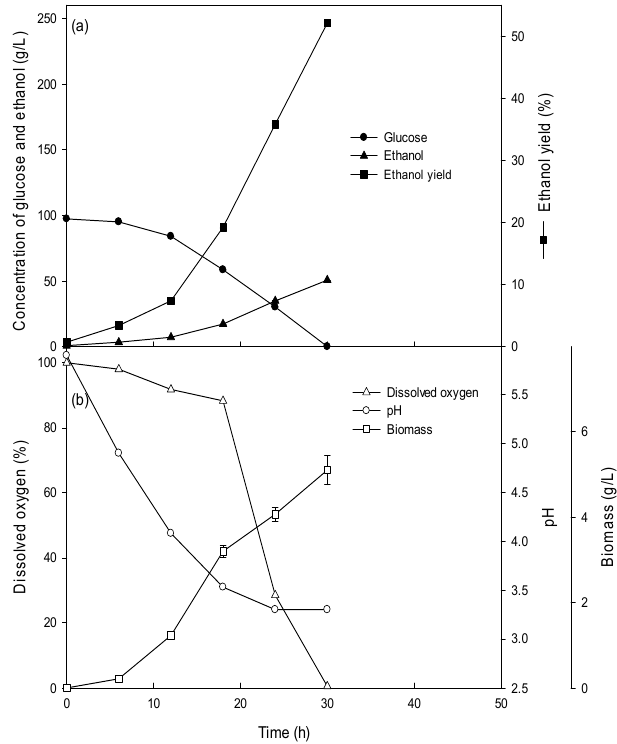
Figure 2. Time course of ( a ) glucose, ethanol concentration, and ethanol yield change, ( b ) dissolved oxygen, pH, and biomass in the batch cultures of S. cerevisiae BCRC 21812. The initial glucose concentration was 10% ( w / v ).